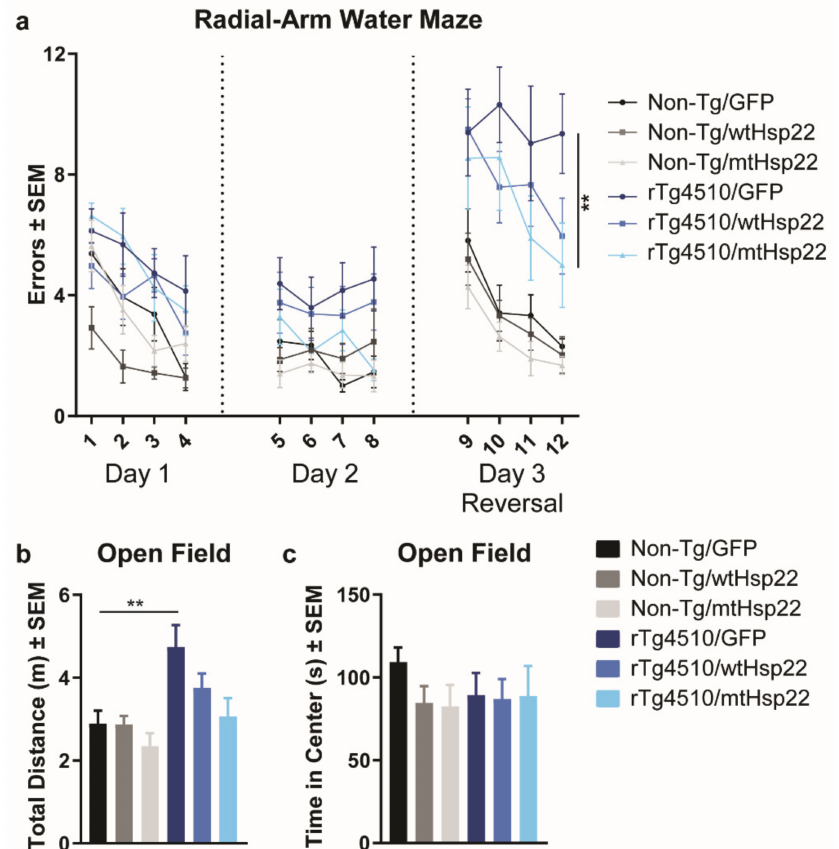
Figure 2. mtHsp22 overexpression rescues spatial reversal learning and memory in rTg4510 mice. ( a ) The 2-day Radial-Arm Water Maze task with reversal was used to assess spatial memory in non- transgenic (Non-Tg) and rTg4510 mice injected with GFP ( n = 10/Non-Tg; n = 10/rTg4510), wtHsp22 ( n = 11/Non-Tg; n = 10/rTg4510), or mtHsp22 ( n = 10/Non-Tg; n = 10/rTg4510). Mice were tested in 12 trials per day for training (Day 1), testing (Day 2), and reversal (Day 3), and the number of errors was recorded. Average errors over each set of three trials is shown (mean ± SEM, ** p < 0.01). Non-Tg and rTg4510 mice injected with GFP ( n = 10/Non-Tg; n = 10/rTg4510), wtHsp22 ( n = 11/Non-Tg; n = 10/rTg4510), or mtHsp22 ( n = 10/Non-Tg; n = 10/rTg451)0 were also evaluated in an open field for ( b ) total distance traveled in meters (m) and ( c ) time spent in the center in seconds (s) over the course of 10 min (mean ± SEM), ** p <